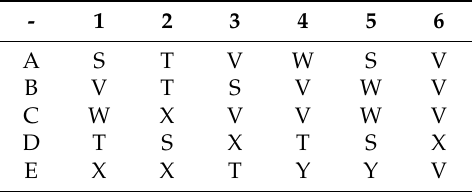
Table 6. The road type from location to the field.